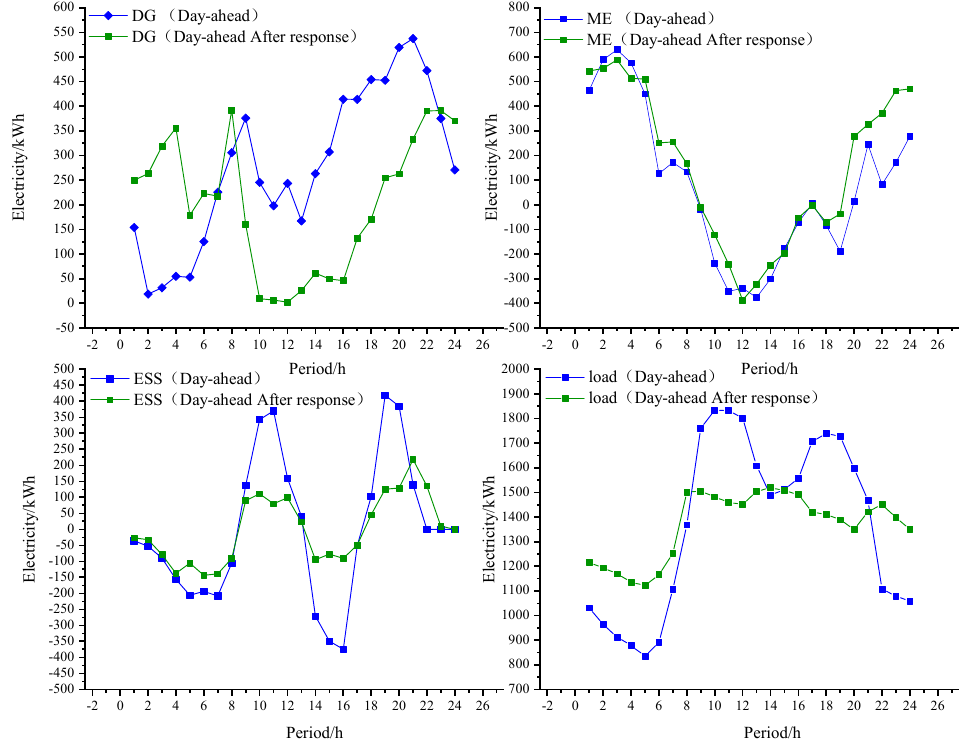
Figure 9. The comparison of day-ahead scheduling of the microgrid before and after demand side management. Table 6. Comparison of the key parameters before and after the implementation of demand response.